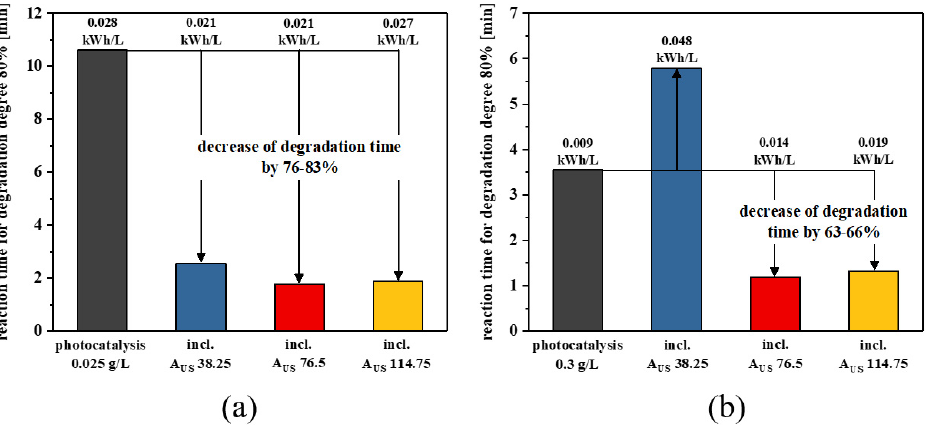
Figure 6. Reaction time for 80% degradation considering the energy consumption of the irradia- tion and sonication depending on the amplitude for the TiO 2 dosages of ( a ) 0.025 g/L and ( b ) 0.3 g/L. For the low-dosage suspension, the degradation time was reduced by 76–83% from 10.5 min to 1.9–2.6 min with sonication and led to synergistic effects of 202–295%.